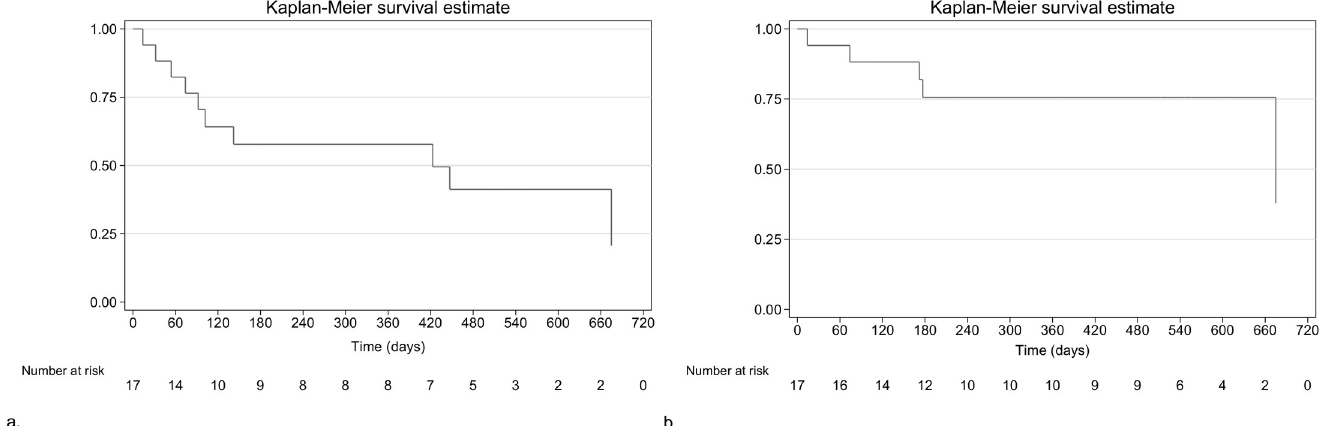
Fig 3. Time to linezolid-related adverse events in children treated for MDR-TB. (a) Kaplan-Meier survival curve for time (in days) to an adverse event of any grade at least possibly related to linezolid; (b) Kaplan-Meier survival curve for time (in days) to a grade 3 or 4 adverse event at least possibly related to linezolid. MDR-TB, multidrug-resistant tuberculosis.